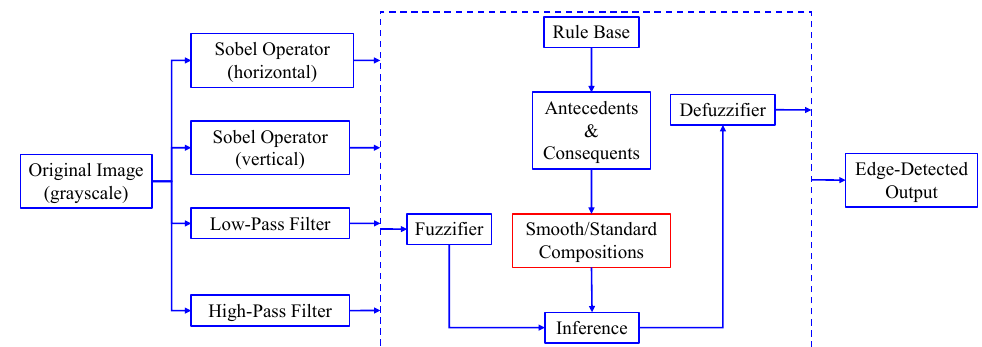
Figure 4. Fuzzy inference